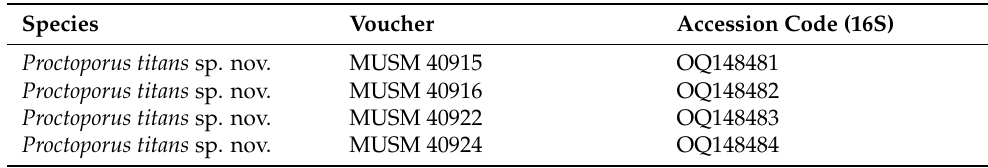
Table A1. GenBank accession codes for new sequences used in the molecular genetic analysis in this study.